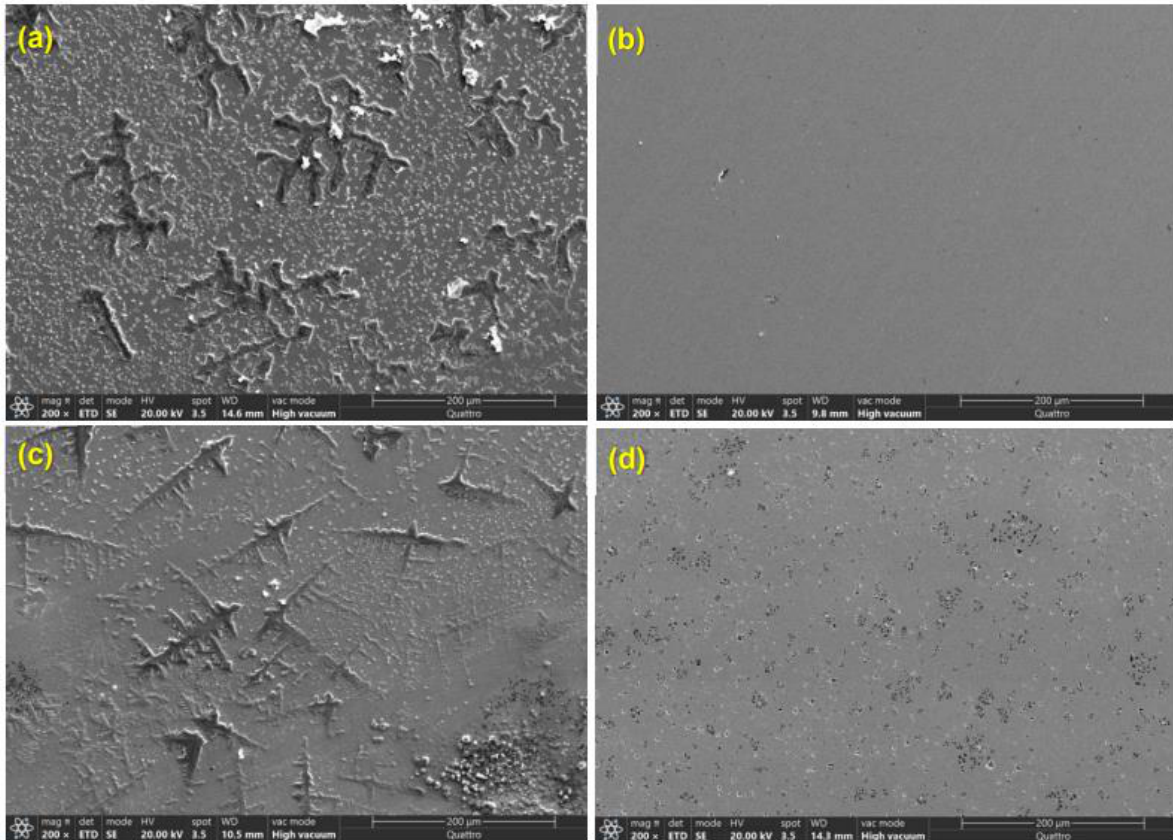
Figure 7. SEM image after impedance measurements for ( a ) AISI 304L and ( b ) AISI 316L and after anodic polarization measurements for ( c ) AISI 304L and ( d ) AISI 316L in seawater at 298 K. Table 6. Average elemental composition of the entire surface for AISI 304L and AISI 316L after impedance (EIS) and potentiodynamic polarization (PD) measurements in seawater at 298 K. AISI 304L AISI 316L Element (wt.%) EIS